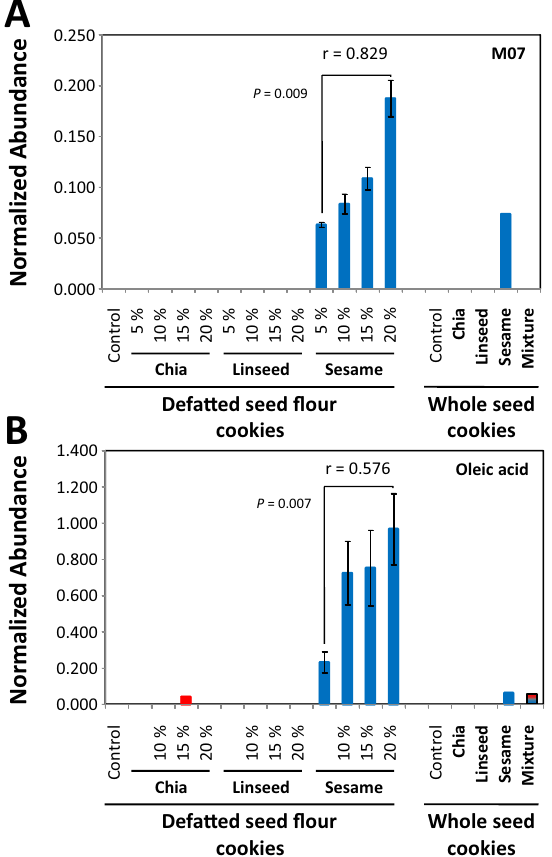
Figure 9. Characterization of a sesame marker and properties of oleic acid in experimental bakery products. Non-targeted metabolite profiling analyses of polar extracts are depicted as described by (Fig. 7). ( A ) Compound M07 was selected as a sesame marker by analyses of non-processed seeds (Fig. 5). M07 was detectable in experimental cookies. M07 is a non-identified compound. ( B ) Oleic acid was eliminated as a potential seed marker by manual curation because a ubiquitous fatty acid obviously has no specificity as a sesame marker. Note that non-targeted analyses may yield potential but non-specific markers, such as in this case oleic acid. Without careful curation, such a marker would lead to misclassifications of food material. Exemplary t -tests are included ( P